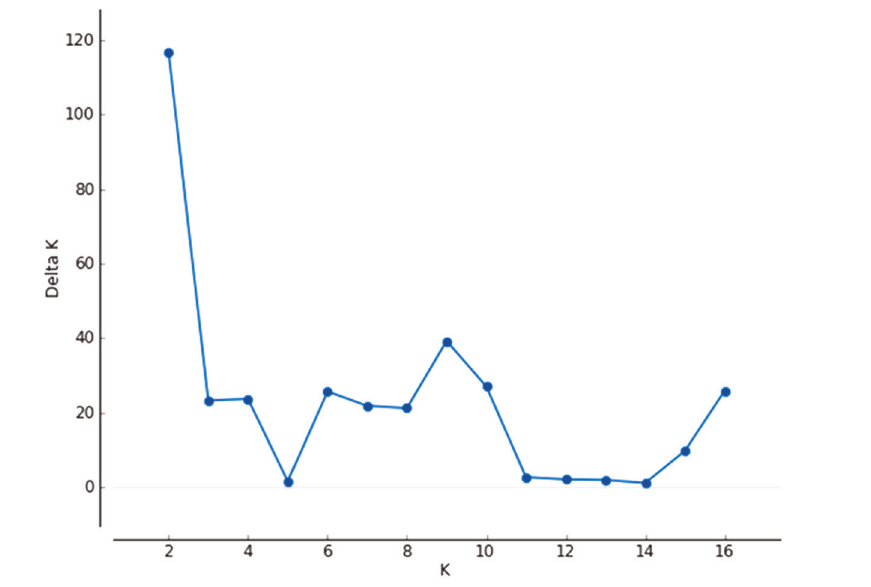
Figure 3. Determination of the most probable cluster number of 16 Limousin herds using ΔK approach on Structure lnP(D) values. ΔK values (five independent runs) for each assessed K value on 16 Limousin populations. The most probable number of clusters was